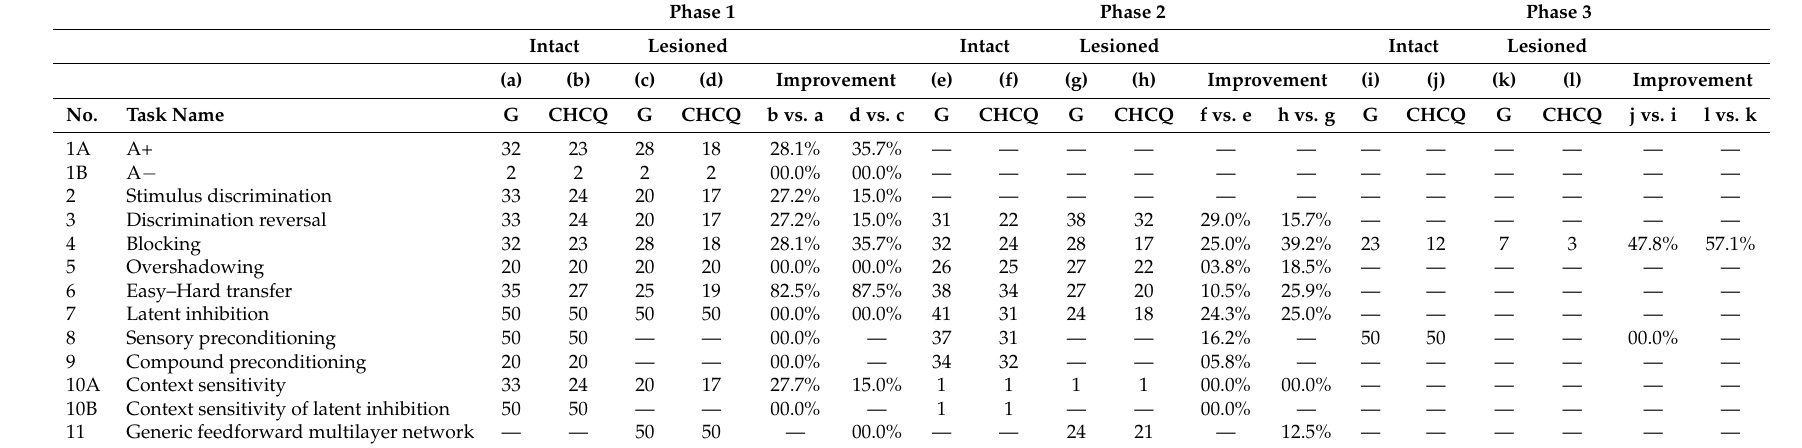
Table 4. A comparison between G (Green model) and the CHCQ model, in terms of trial numbers needed to get the final state of